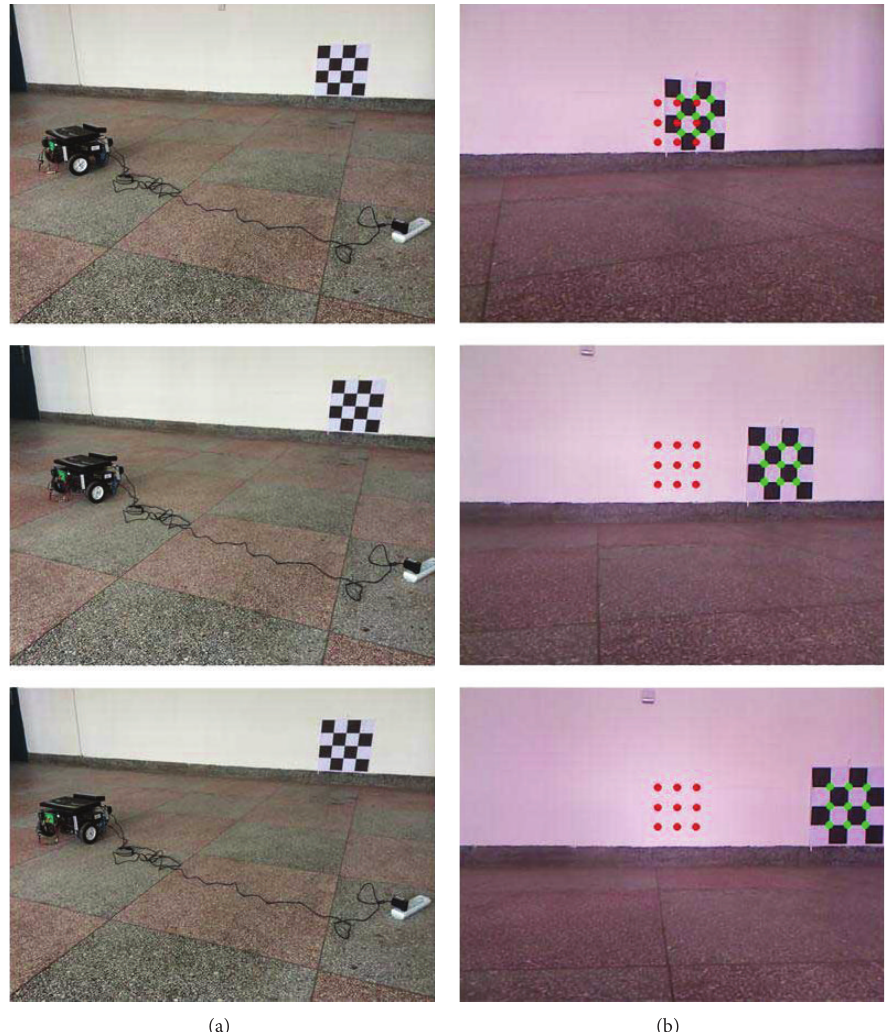
Figure 20: Experimental results. Snapshots of the robot motion (a) during the first step. Also, snapshots of the feature motion (b) superimposed on the current